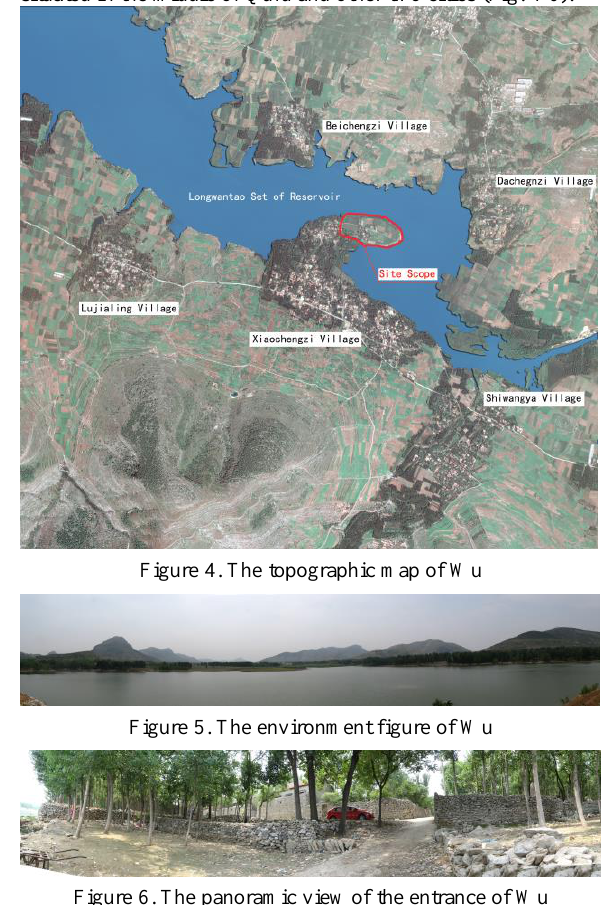
Figure 6. The panoramic view of the entrance of Wu Back against the mountain, Huangyue was located on a platform in a valley beside a mountain route through the hilly region to Qufu directly; guarded and commanded the route, with the main peak of Phoenix Mountain as beacon tower